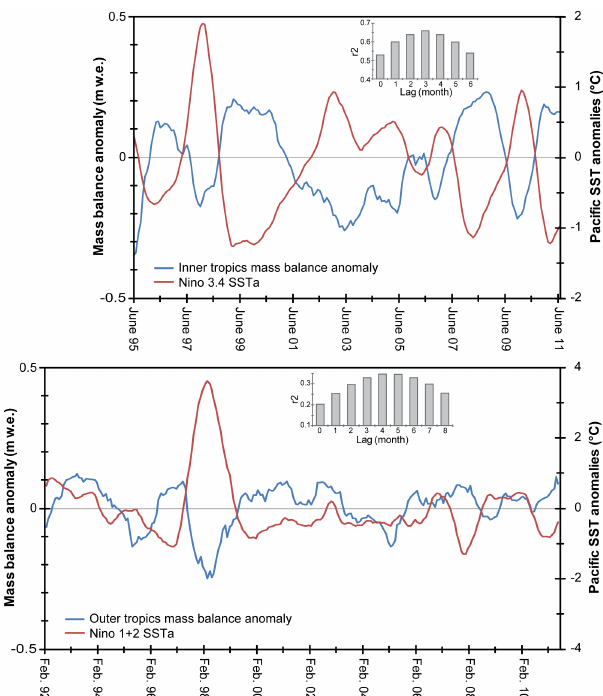
Fig. 9. Upper graph: time series of monthly mass balance anomalies (mw.e.) for the inner tropics (mean of Antisana 15 and La Conejeras glaciers) and Ni˜no3.4 SSTa ( ◦ C) between June 1995 and August 2011. Both time series were smoothed with a 12-month averaging filter. Mass balance anomalies lag SSTa by 3months. Vertical bar plot (inset) shows the correlation between mass balance anomalies and the Ni˜no3.4 index, with the Ni˜no3.4 index leading mass bal- ance anomalies by between 0 and 6months. Lower graph: the same but for the outer tropics (mean of Zongo, Chacaltaya and Charquini Sur glaciers) and Ni˜no 1+2 SSTa. The best correlation between both series was with a 4-month lag (see the vertical bar plot